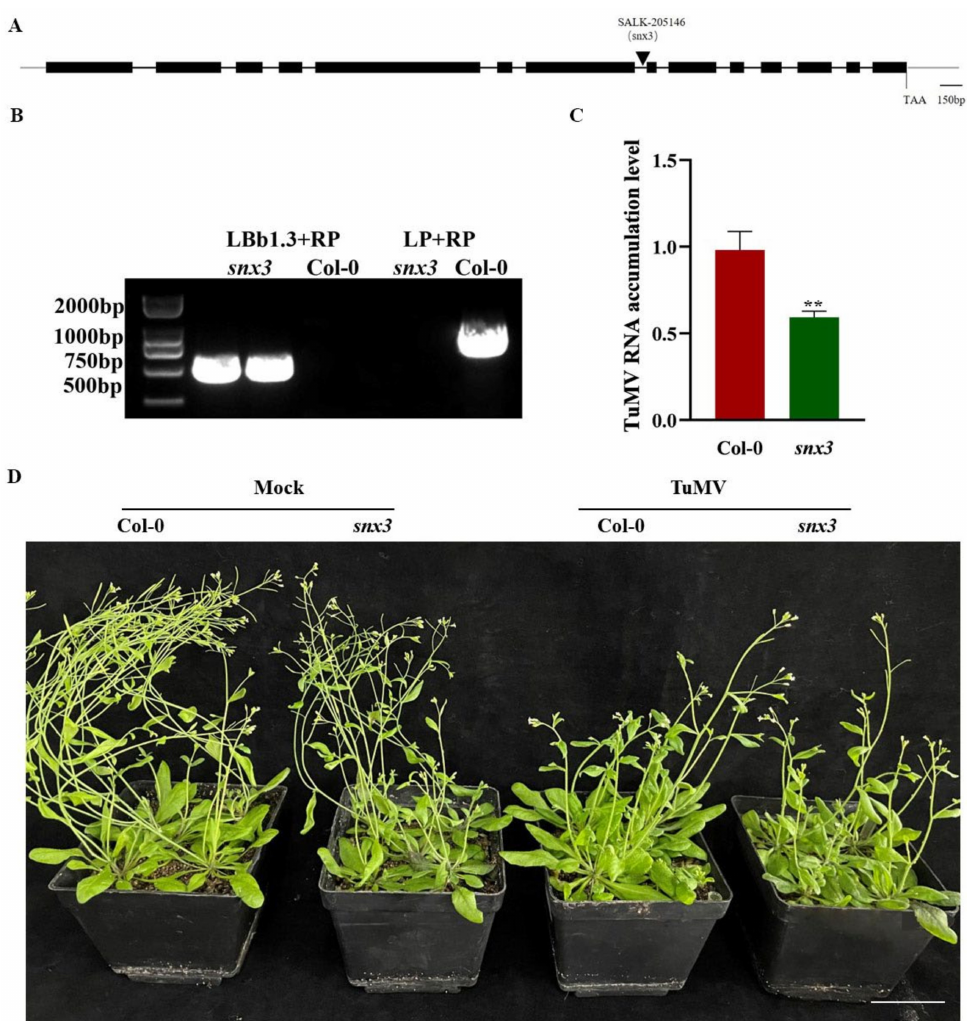
Figure 8. TuMV infection was inhibited by AtSNX3 gene knockout in Arabidopsis. ( A ) Schematic diagram of the AtSNX3 gene structure. The relative position of the T-DNA insertion site is shown. Exons are represented by black boxes. ( B ) PCR genotyping of the snx3 mutant. ( C ) qRT-PCR analysis of TuMV RNA level in the wild-type and snx3 mutant under TuMV infection at 15 dpi. The expression level of TuMV genomic RNA in wild-type Col-0 plants was set to 1. Error bars represent the SD of three times experiments. Statistical analysis was performed using Student’s t -test (** p < 0.05). ( D ) The phenotype of the wild-type (Col-0) and snx3 mutant plants inoculated with TuMV or mock infection at 15 dpi. Bars = 5